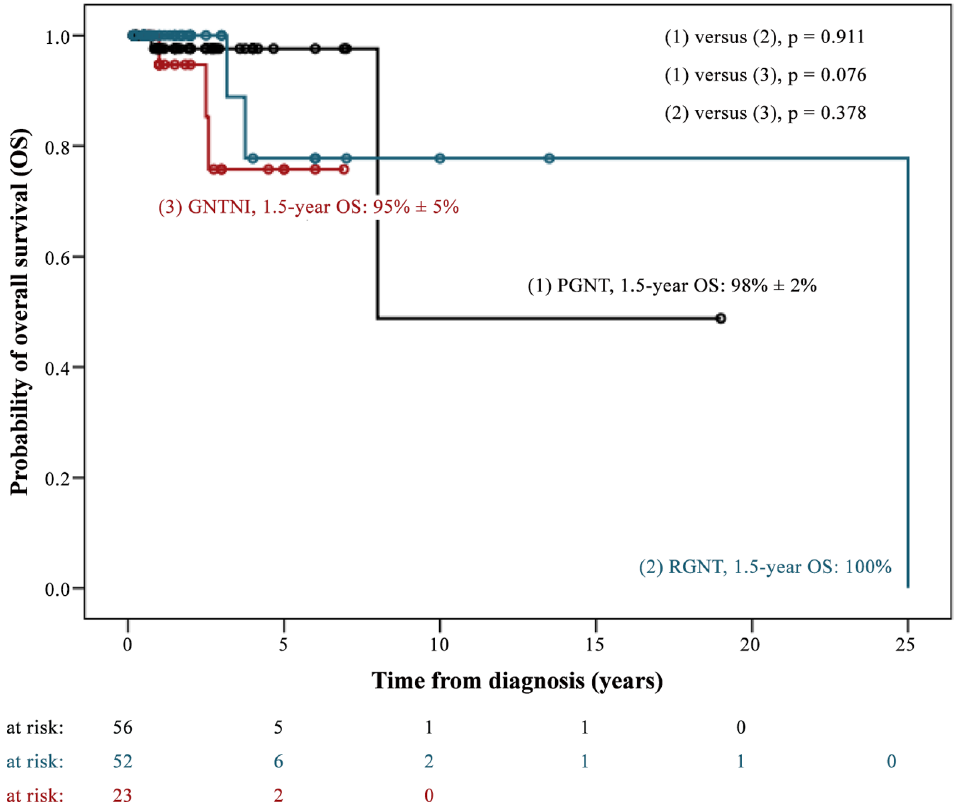
Figure 4. Kaplan-Meier Plot OS.